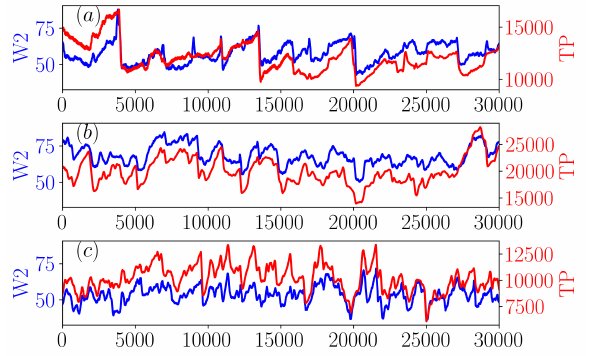
Figure 4: W 2 distance and total persistence, corresponding to the experiments shown in Fig. 3.